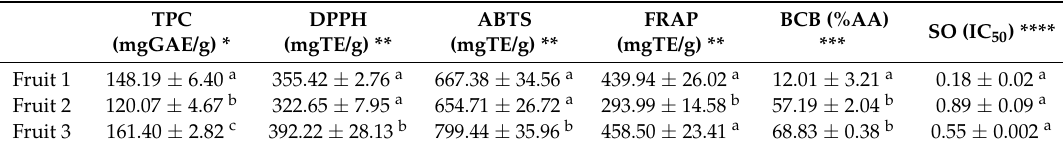
Table 1. Antioxidant activity of three different n -butanol extracts of baobab fruit